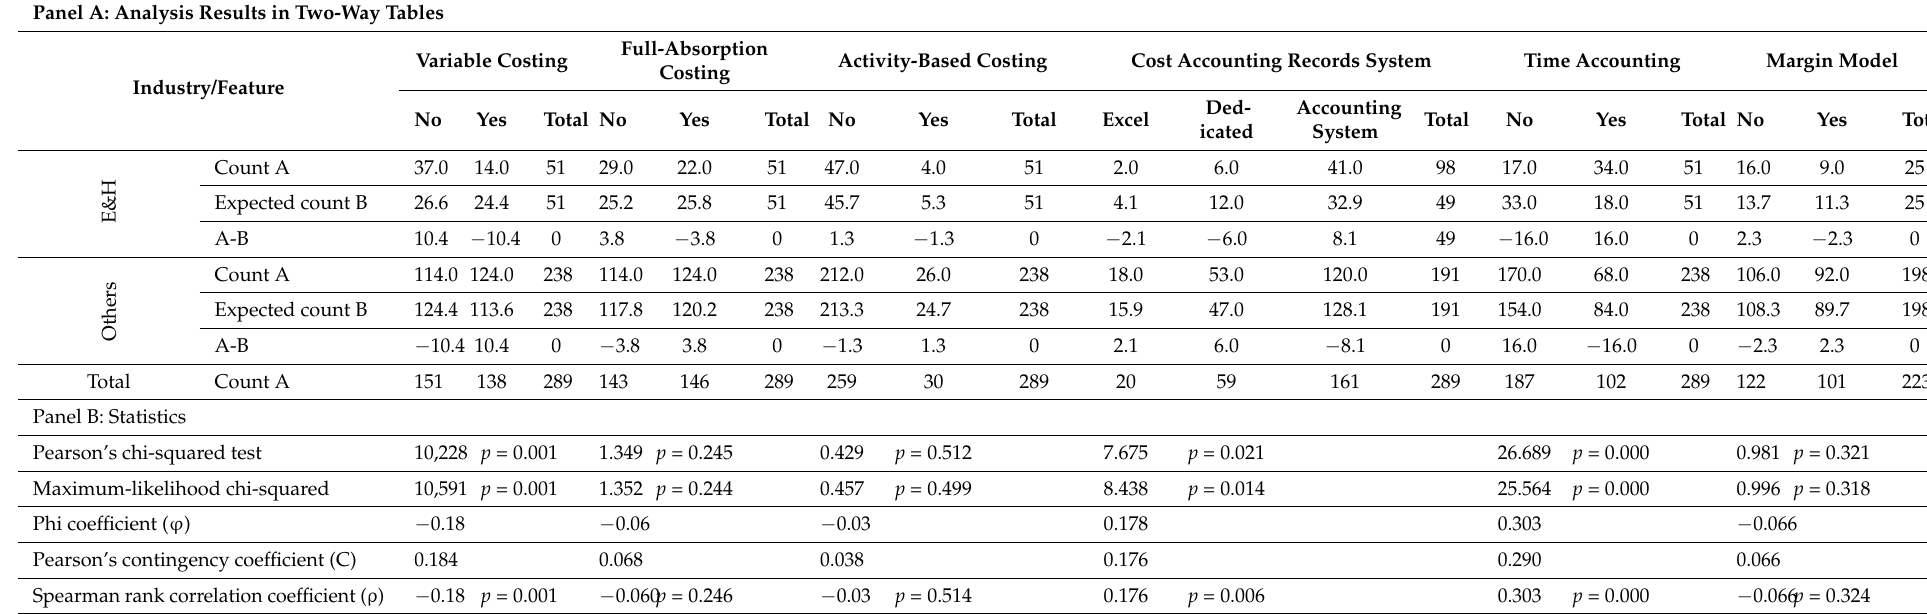
Table 7. Cost accounting and cost management in the surveyed